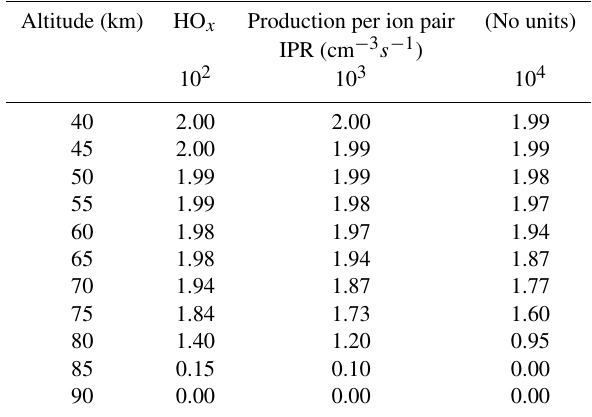
Table E1. HO x production per ion pair as a function of altitude and ion pair production rate (IPR). Table adapted from Jackman et al. (2005b). Altitude (km) HO